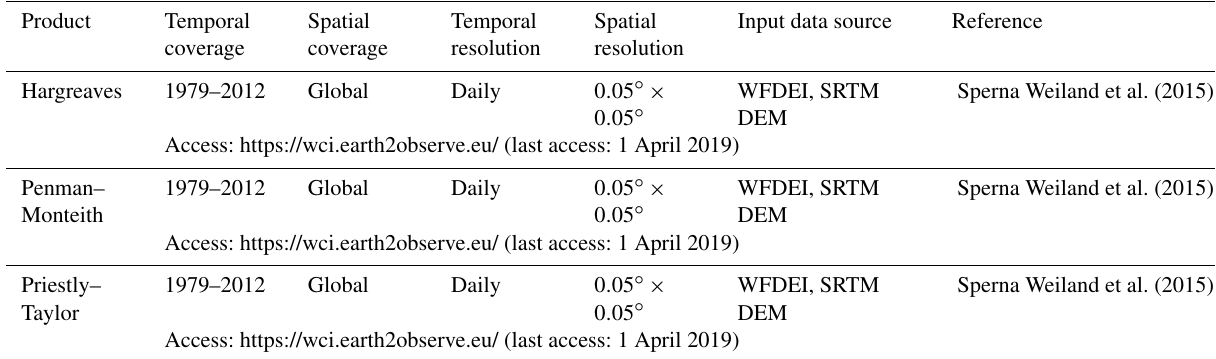
Table 5. Characteristics of potential evapotranspiration products.